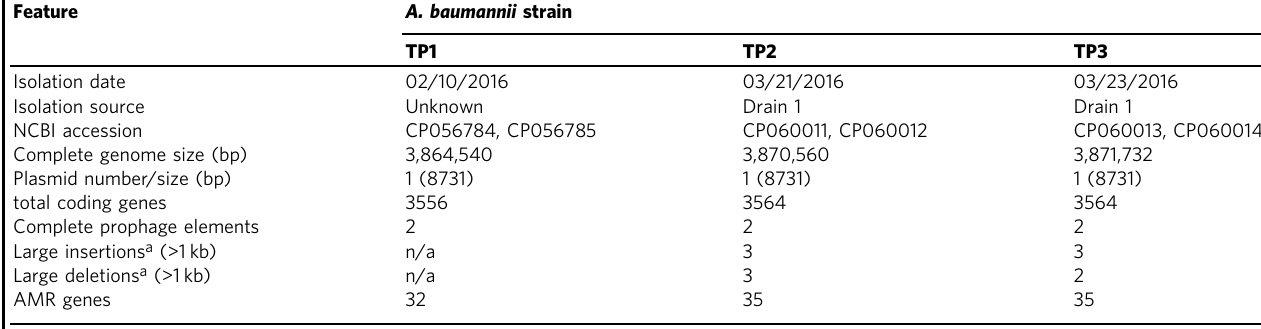
Table 3 Summary of genome features and genetic changes observed in A. baumannii strains TP2 and TP3 relative to TP1.